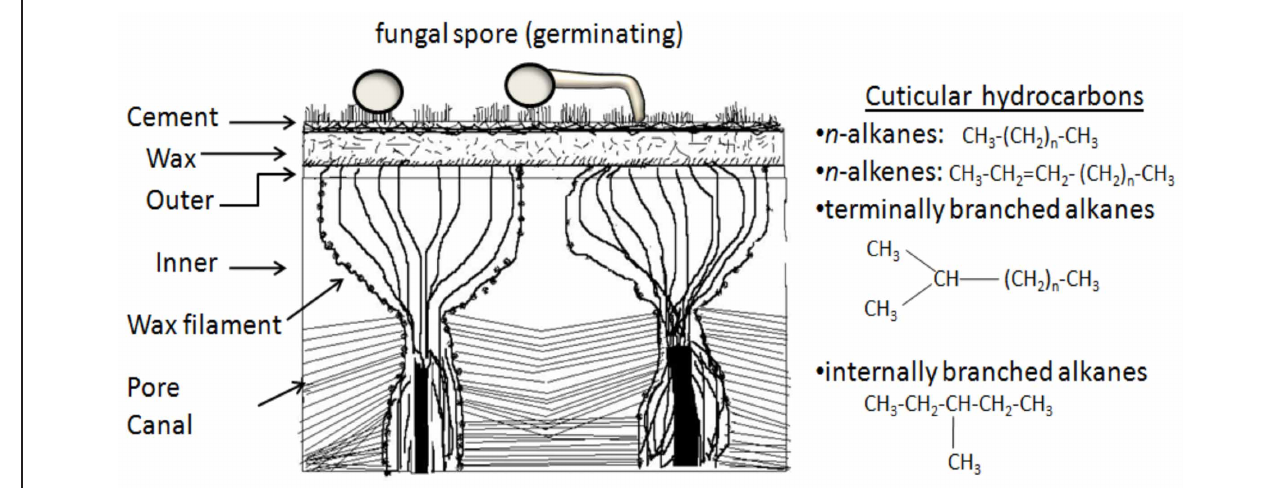
FIGURE 2 | Initial aspects of the fungal-insect interaction: the insect cuticle and its hydrocarbon contents. Image adapted from (Noble-Nesbitt, 1991). The inner, outer, wax, cement, and bloom layers are often considered